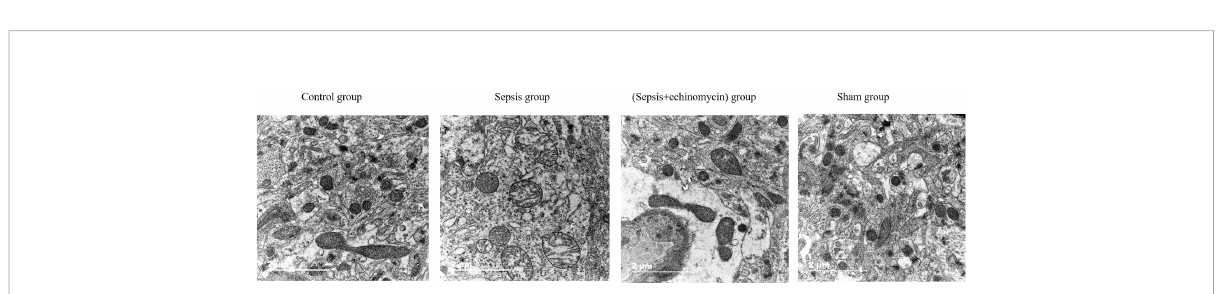
FIGURE 9 HIF-1 a and BNIP3L pathway induced neuronal mitochondrial damage. Compared with other three groups, the mitochondria in the sepsis group underwent obvious swelling, mitochondrial morphological changes, and mitochondrial vacuolization.